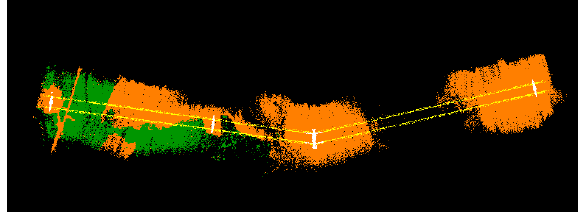
Figure 4. Top view of corridor and line laser point cloud